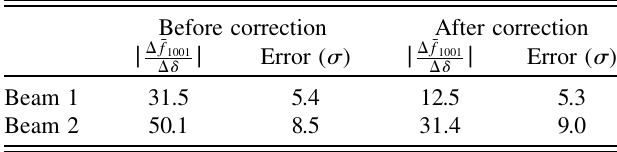
TABLE II. The weighted mean value of the chromatic f 1001 and its standard deviation, before and after correction, for beam 1 and beam 2, respectively. Before correction